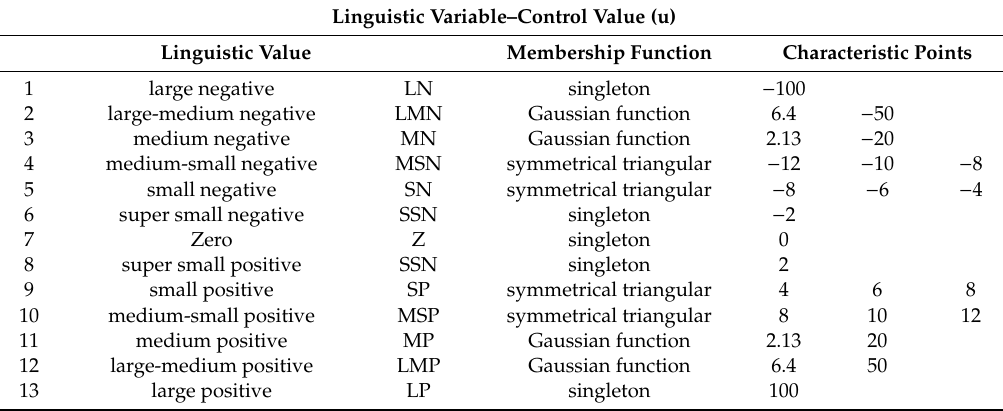
Table 9. The second version of the controller–control value.